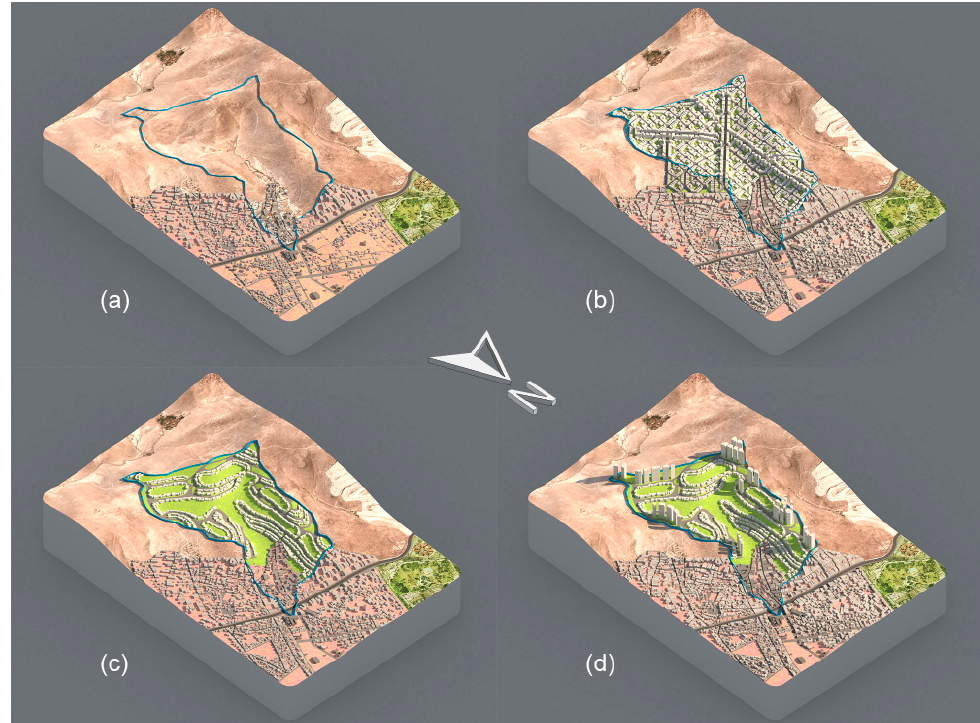
Figure 4. Scenario modeling according to urbanization level of ( a ) current situation (without urbanization), ( b ) high urban density, ( c ) low urban density (green area), and ( d ) high urban density (green area).